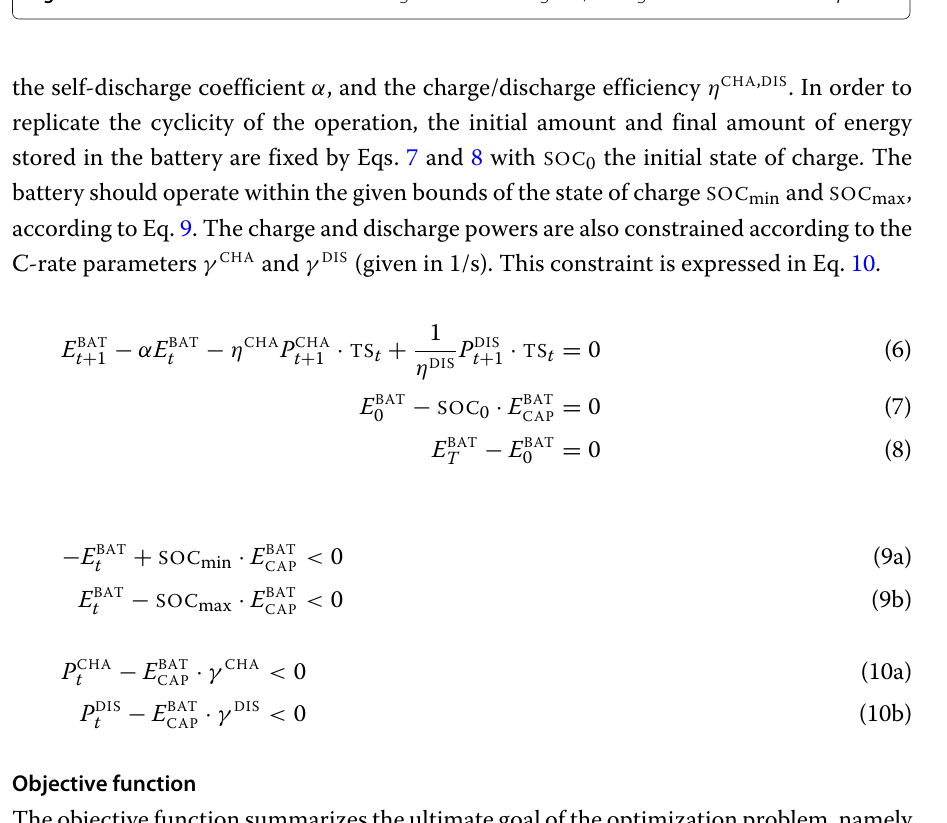
Fig. 2 Distance D between two modules for a given module height H , tilt angle α and solar elevation β